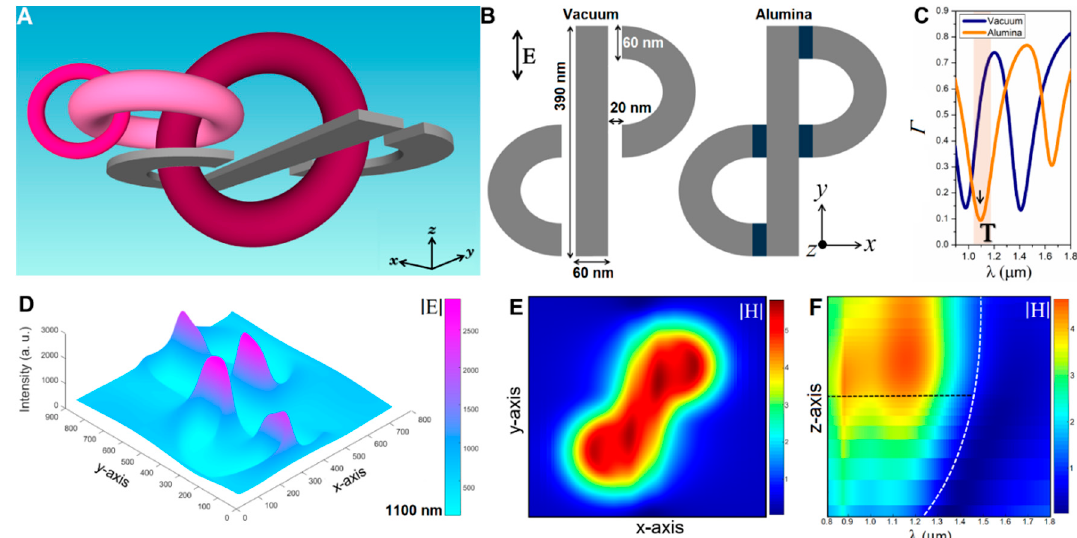
Figure 2. ( A ) An artistic rendering of the proposed toroidal plasmonic meta-atom, holding multiple twisted loop-currents. ( B ) Top-view images of the unit cell for the absence and presence of an alumina spacer at the gaps with a description of the geometrical sizes. ( C ) Transmission ( Γ ) amplitude for the excitation of the toroidal feature under polarized normal beam excitation for two different analyzed regimes. ( D ) The 3D |E|-field map for the excitation of the toroidal feature in the presence of an alumina spacer at the resonance wavelength ( λ ~1100 nm). ( E ) The 2D |H|-field map for the excitation and localization of the magnetic field, leading to inducing an oblique toroidal feature at 1100 nm. ( F ) The cross-sectional |H|-field snapshot as a function of the incident beam, validating emission of a huge field from the toroidal scatterer at the resonance wavelength.